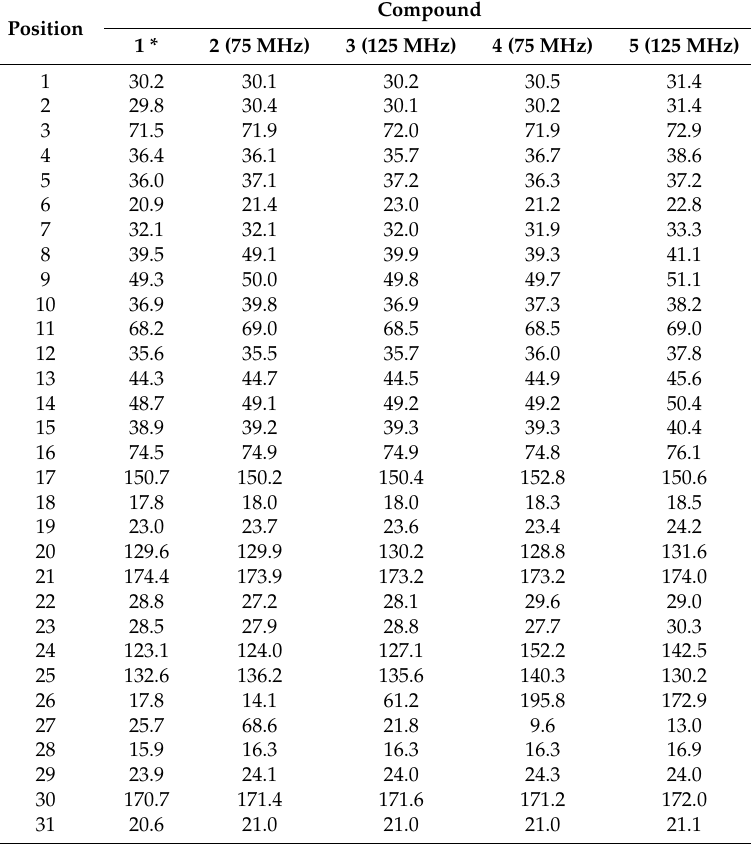
Table 2. 13 C-NMR data of fusidic acid and the isolated metabolites. δ C ppm.